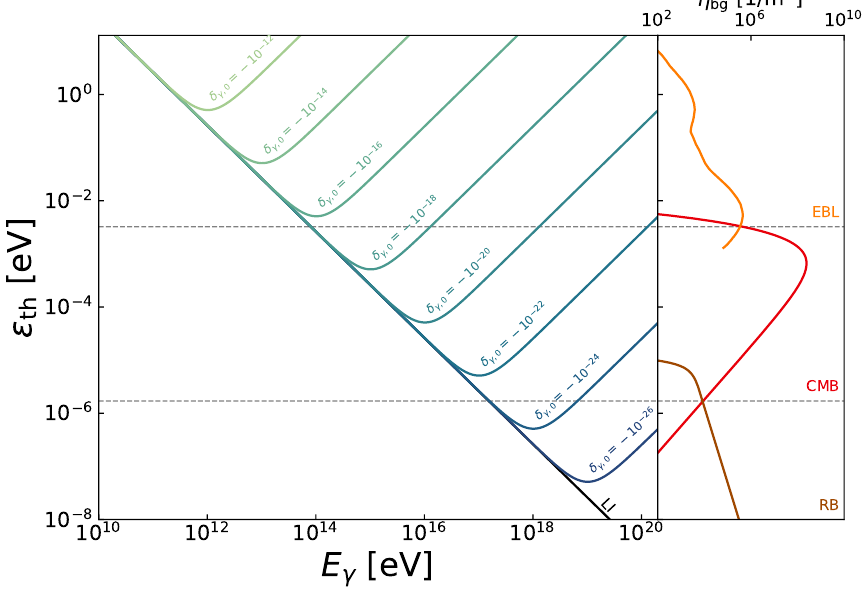
Figure 1. Energy threshold for the pair production as a function of the energy of the propagating photon. The black line shows the results for a LI assumption, while the different colored lines show the results for different subluminal LIV coefficients. The right panel shows the background distribution for that given energy. The dashed lines indicate the region in which each background is dominant. For the EBL, the model in [38] was used as an example. For the RB, the parameterization from [39] was